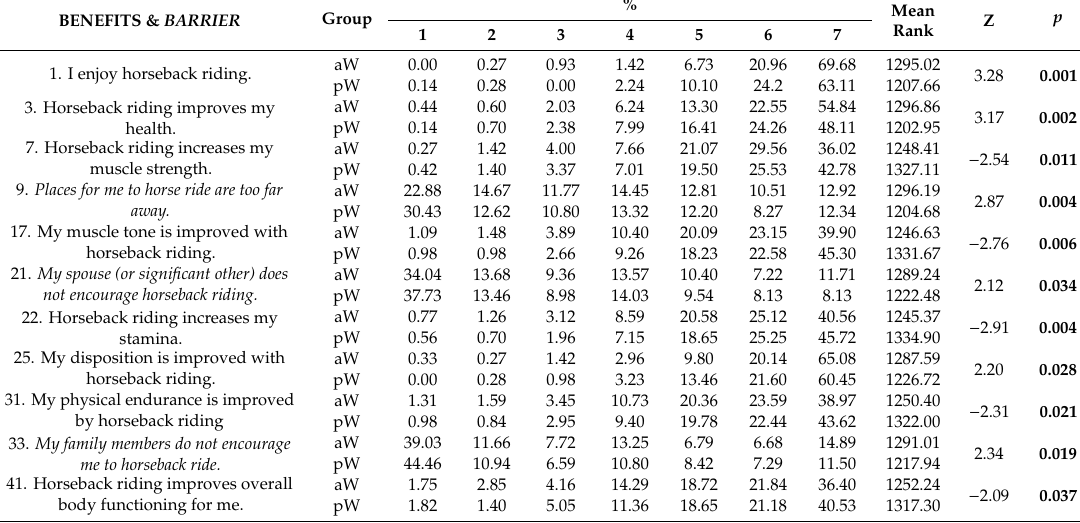
Table 7. Comparison of female participants based on specialized degree: amateurs (n = 1827) vs professionals (n = 713), ( p < 0.05). (1–7 Likert scale: 1—this issue concerns me to a very low